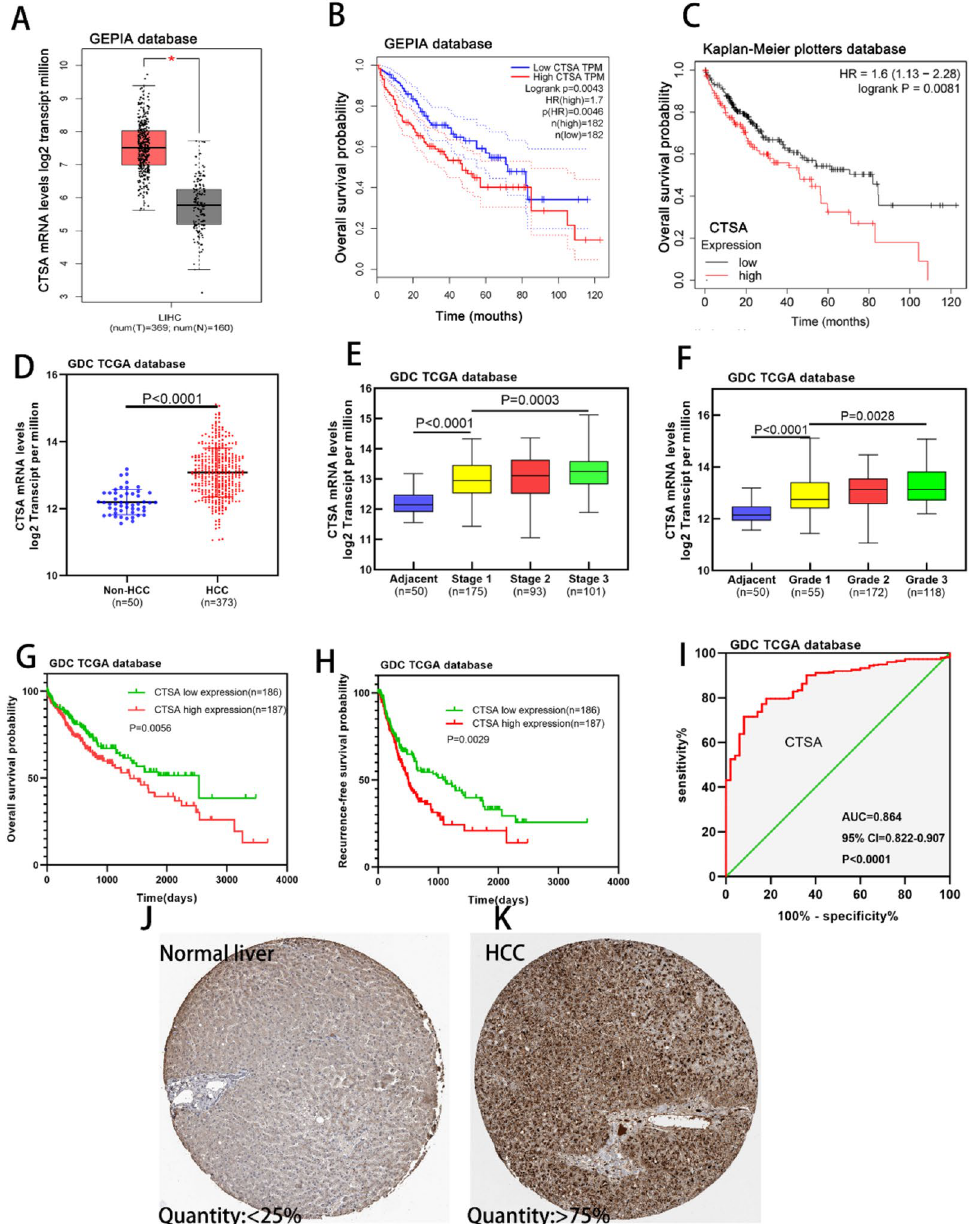
Figure 2. Analysis of CTSA expression and prognostic value of HCC patients in the TCGA database. ( A ) The CTSA expression level in hepatocellular carcinoma was significantly higher than normal liver tissues in the GEPIA database ( P < 0.05). ( B , C ) High CTSA expression level was associated with poor overall survival (OS) in patients with HCC in the GEPIA website and Kaplan–Meier plotters database. ( D ) The CTSA expression level in HCC was significantly higher than None-HCC tissues in the TCGA database ( P < 0.0001). ( E , F ) The CTSA expression in HCC was incrementally upregulated with increasing tumor stages and neoplasm histology grades in the TCGA database. ( G , H ) Kaplan–Meier curves of overall survival (OS) and recurrence-free survival (RFS) among different CTSA expression among HCC patients in the TCGA database. High CTSA expression associated with poor OS (G, P = 0.0056) and RFS ( H , P = 0.0029). ( I ) The receiver operating characteristic (ROC) curve showed that the CTSA expression level can be used as evidence to predict the prognosis of HCC patients (AUC = 0.864, P < 0.0001). ( J , K ) Representative images in the Human Protein Atlas database showed that the expression quantity of CTSA protein in HCC tissues (> 75%, K ) was higher than normal liver tissues (< 25%, J